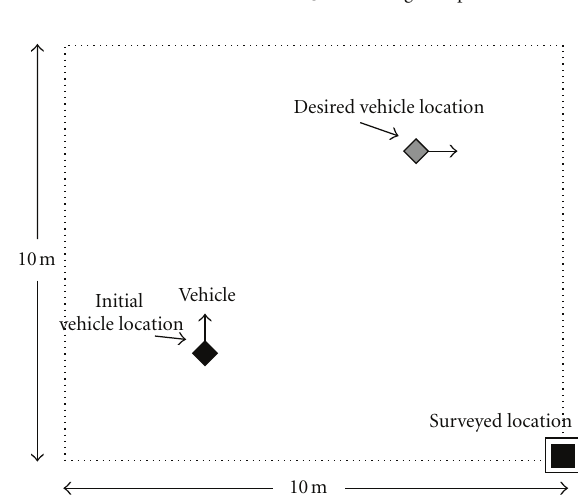
Figure 1: Example scenario of an autonomous vehicle using two sensors to achieve a specific end location.